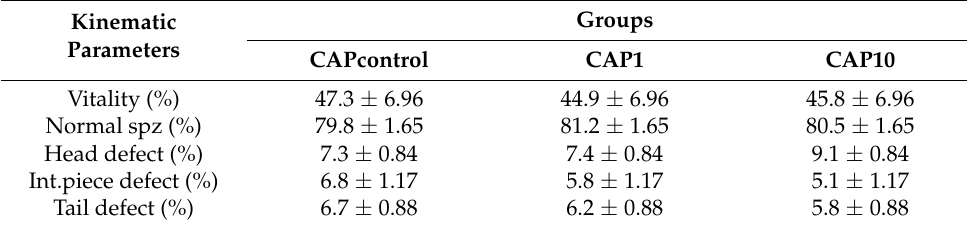
Table 2. Sperm vitality, head, intermediate piece and tail anomalies, concentration, and mitochondrial membrane potential after the capacitation with AntiOxBEN2.